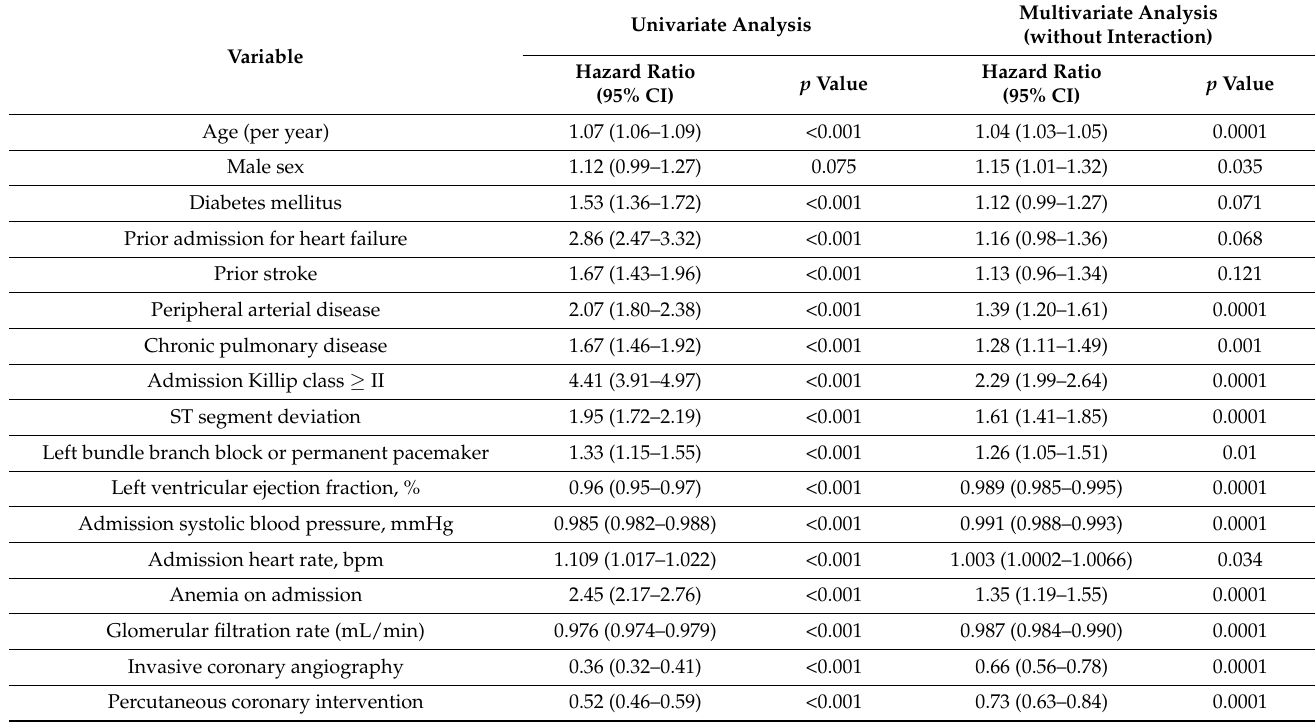
Table 2. Predictors of mortality at one-year